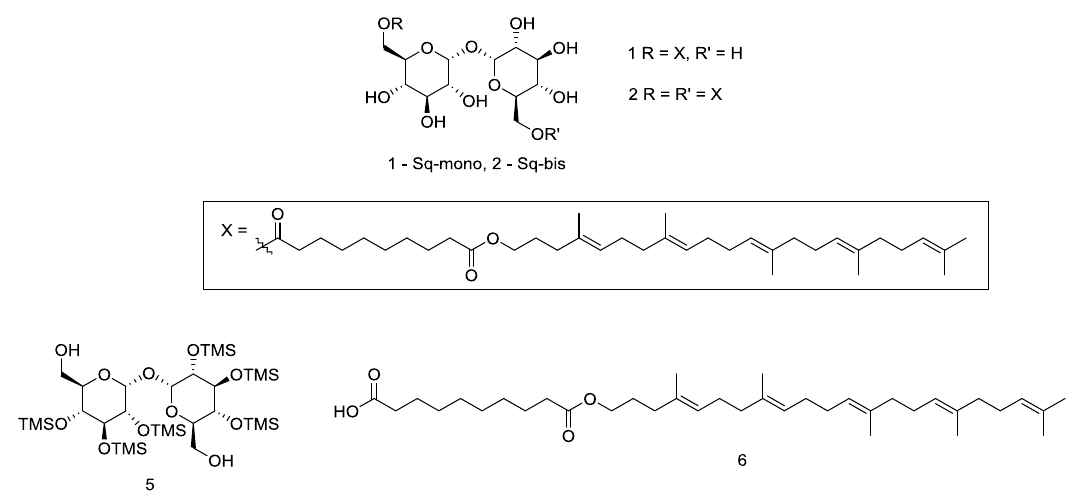
Figure 2. Chemical structure of target squalene-trehalose conjugates 1-Sq-mono and 2-Sq-bis , and